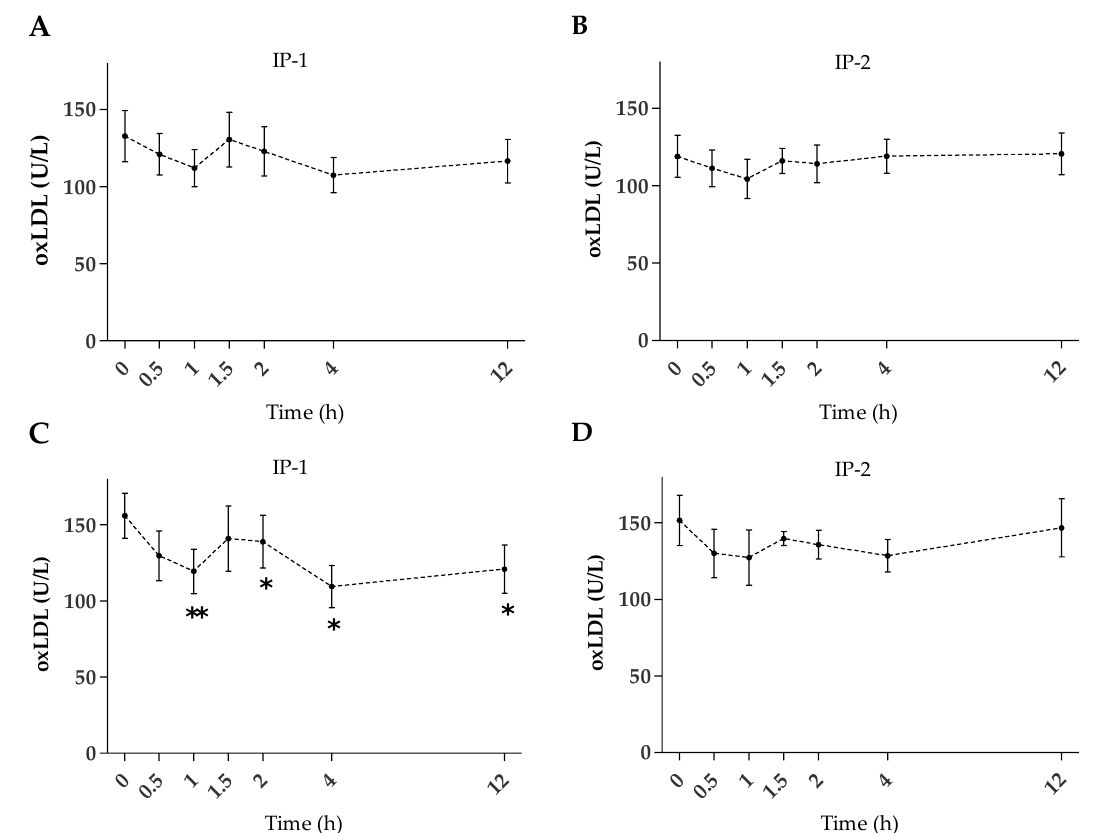
Figure 2. Mean plasma oxLDL concentration over time before (0 h) and after dietary interventions. ( A ) IP-1 (n = 12), ( B ) IP-2 (n = 13), and using the highest oxLDL concentration at baseline ( C ) IP-1 (n = 9), and ( D ) IP-2 (n = 7). Bars: SEM. Significantly different from baseline with *: p < 0.05, and **: p < 0.01.